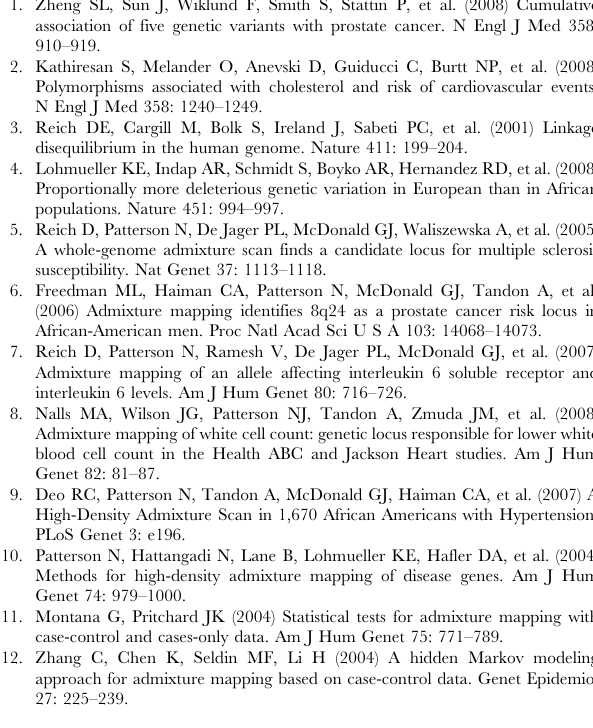
Table S5 Effect size of LPL variants on HDL-C levels. P-values for association of HDL-C with genotype in the total population (p_hdl_all) and for the significance of the genotype 6 local ancestry term in the linear regression model. SNPs with p , 0.0006 are shown in bold. The change in HDL-C level (mg/dL) per LPL allele is shown with standard error for the total population (effect_all), JHS-AFR-2 LPL (effect_afr) and JHS-EUR-1_2 LPL (effect_eur). The SNP frequencies in the total population (f_all), JHS-AFR-2 LPL (f_afr) and JHS-EUR-2 LPL (f_eur) are also shown, as well as the chromosomal position in bases on chromosome 8. Table S6 Multi-SNP models derived using nested regression models and ANOVA for a) TG and b) HDL-C. The most frequent solutions are shown for the 100 runs performed (one run per set of 3300 unrelated